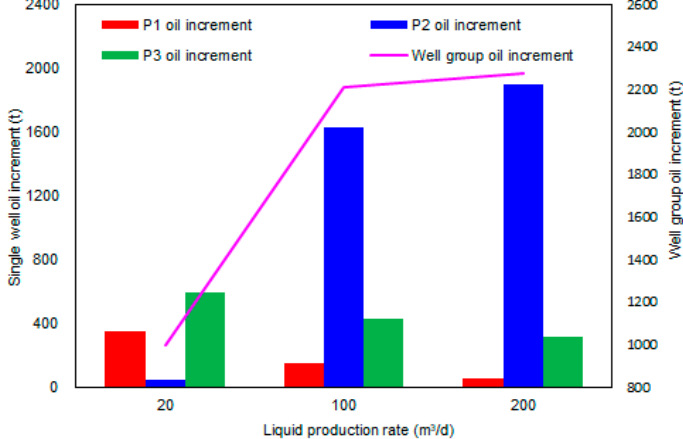
Figure 30. Oil increment at different liquid production rates.